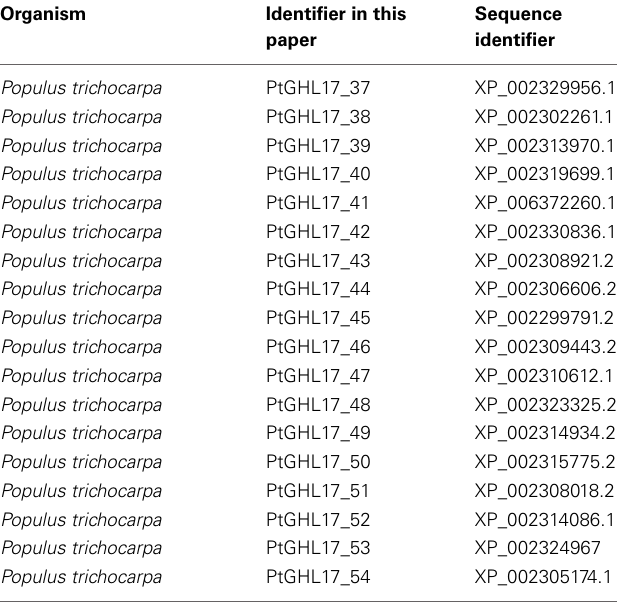
Table 2 | Classification of embryophyte sequences based on protein structure and phylogenetic